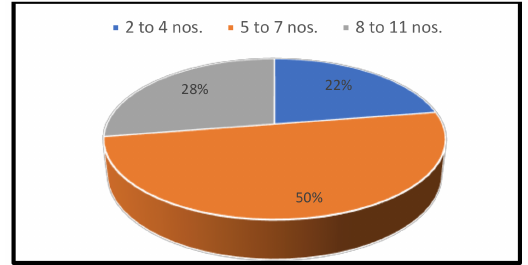
Figure 11. Family size of the seed